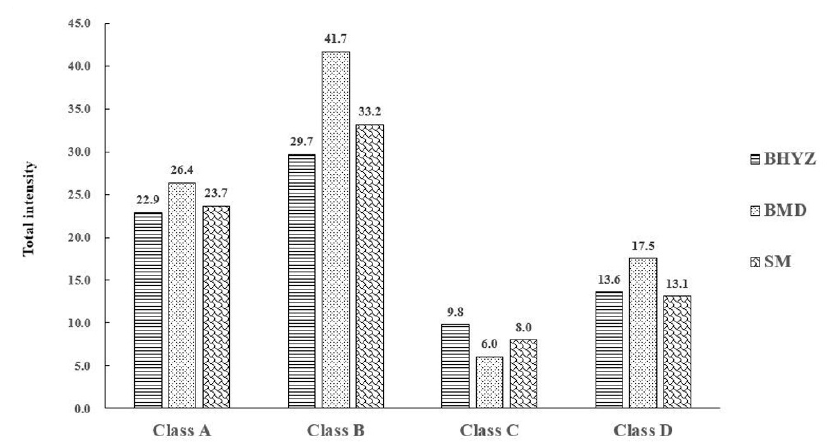
Figure 4. Total intensities of aroma-active compounds belonged to different classes (A: herbal-like odors; B: pleasant (floral, fruity, sweet) odors; C: baked odors; D: unpleasant odors) in three subtypes of white teas.